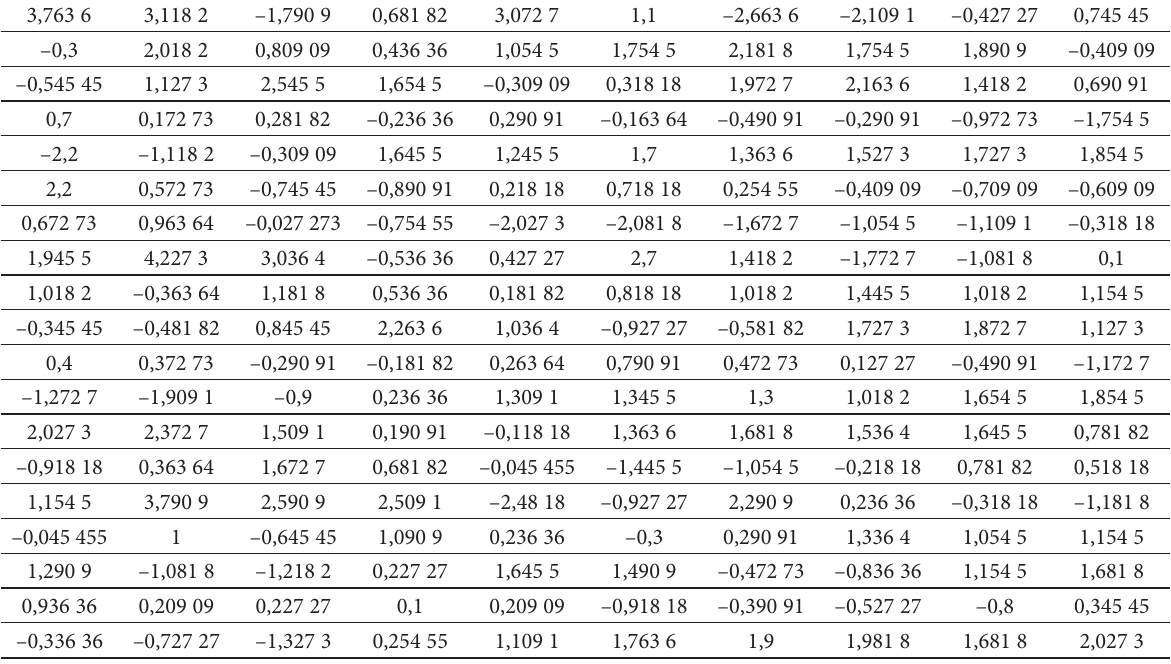
Table 2. Part of a matrix of the covariance function values of the two scales sections by the moving quantation interval, pix 2